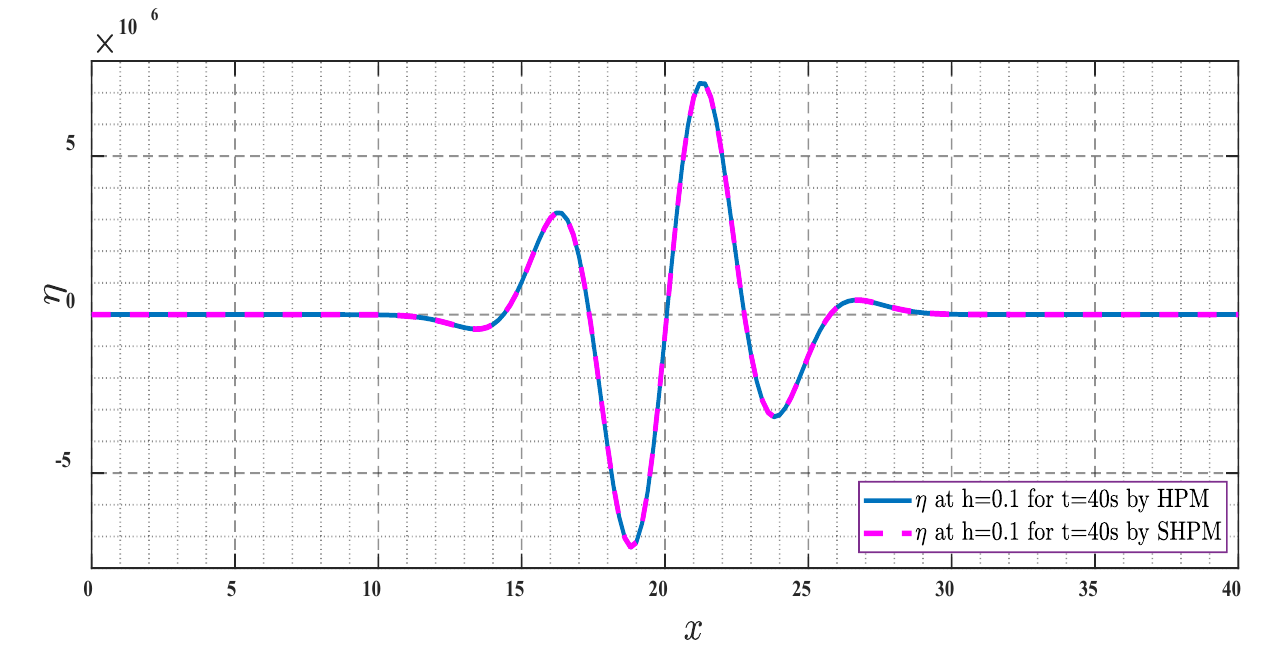
Figure 10. WSE ( η ) by SHPM and HPM at t = 40 s ( h = 0.1).